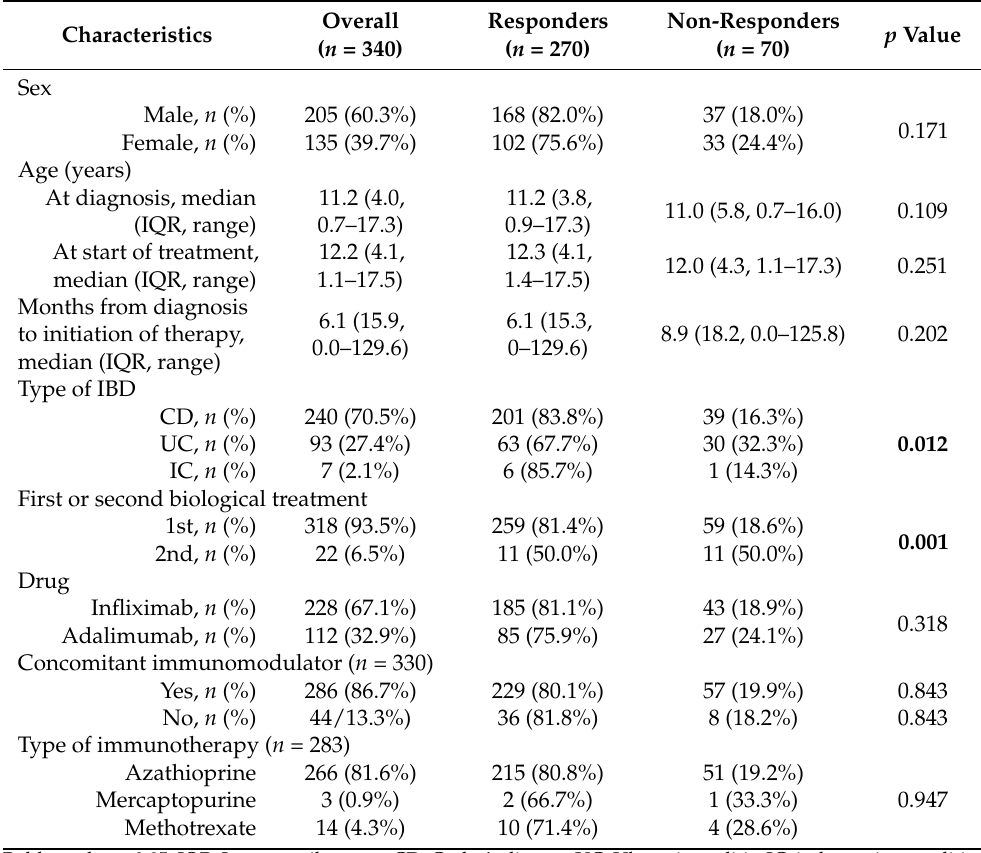
Table 1. Characteristics of pediatric patients.